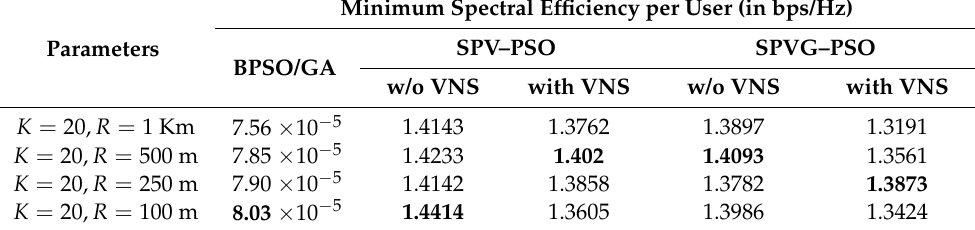
Table 5. Minimum spectral efficiency per user in different cell sizes. The best value for each algorithm is marked in bold